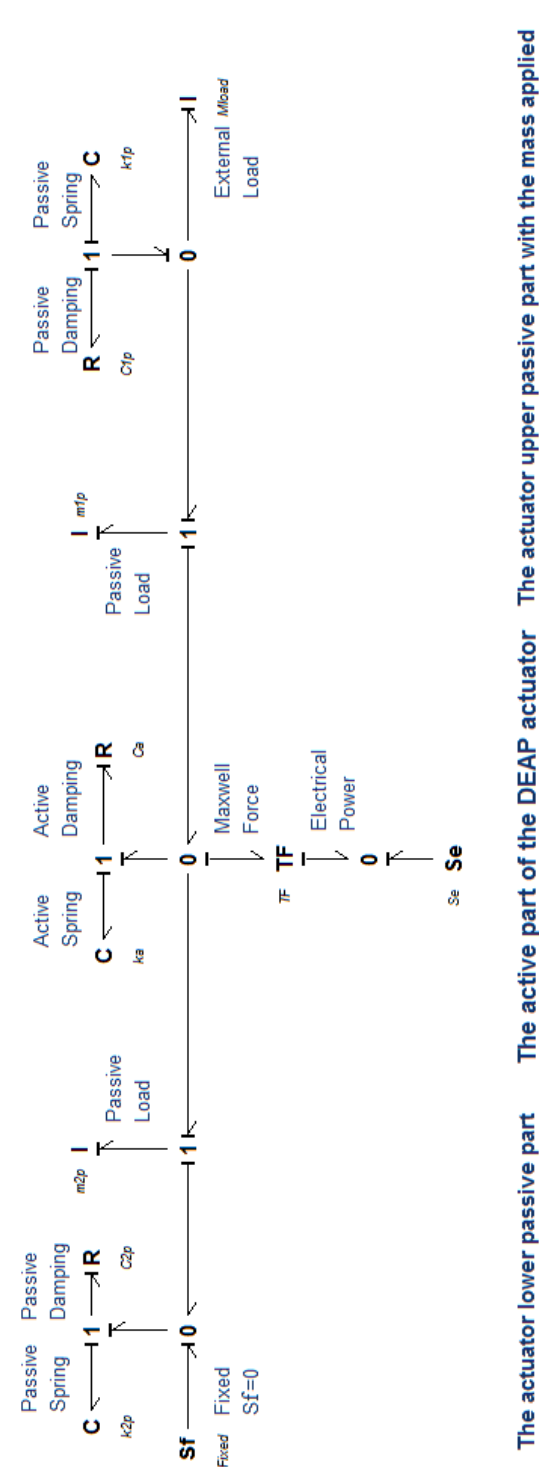
Figure 10: The DEAP push actuator model using the Bond